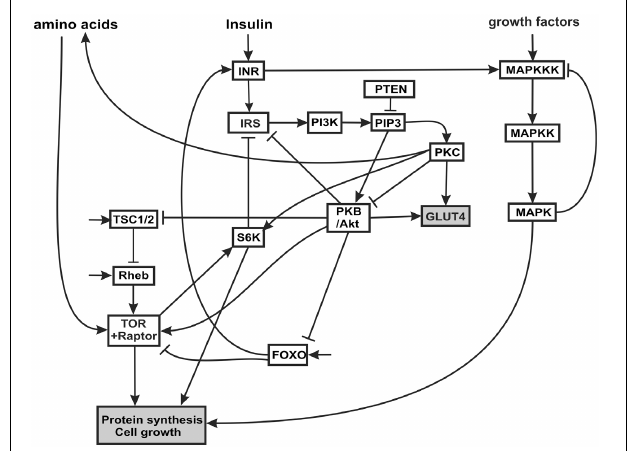
FIGURE 1 | Insulin and MAPK signaling network. The acronyms for the components of the network and the rationale for the connectivity are explained in the